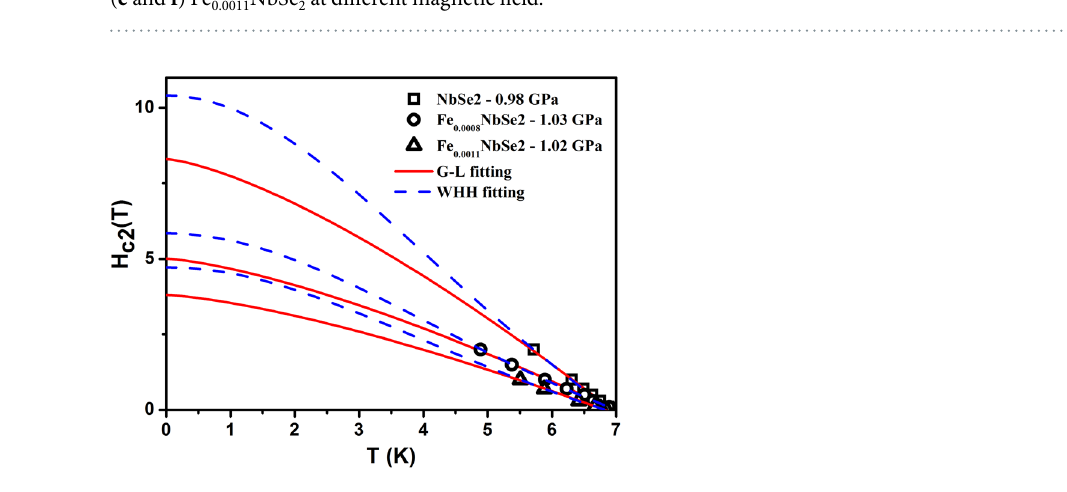
Figure 3. Temperature dependent upper critical field for the Fe x NbSe 2 (x = 0.0008 & 0.0011). Solid lines are represent to fit the Ginzburg–Landau